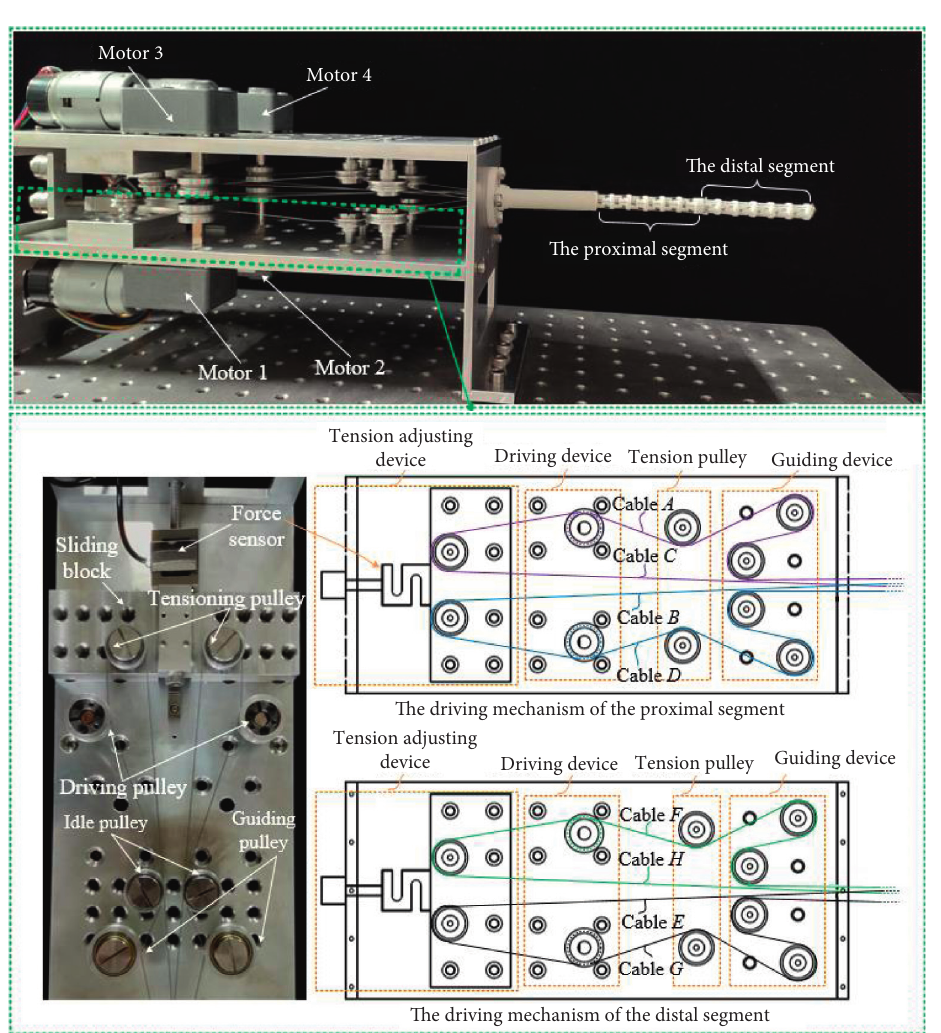
Figure 13: Cable-driven hyper-redundant robot